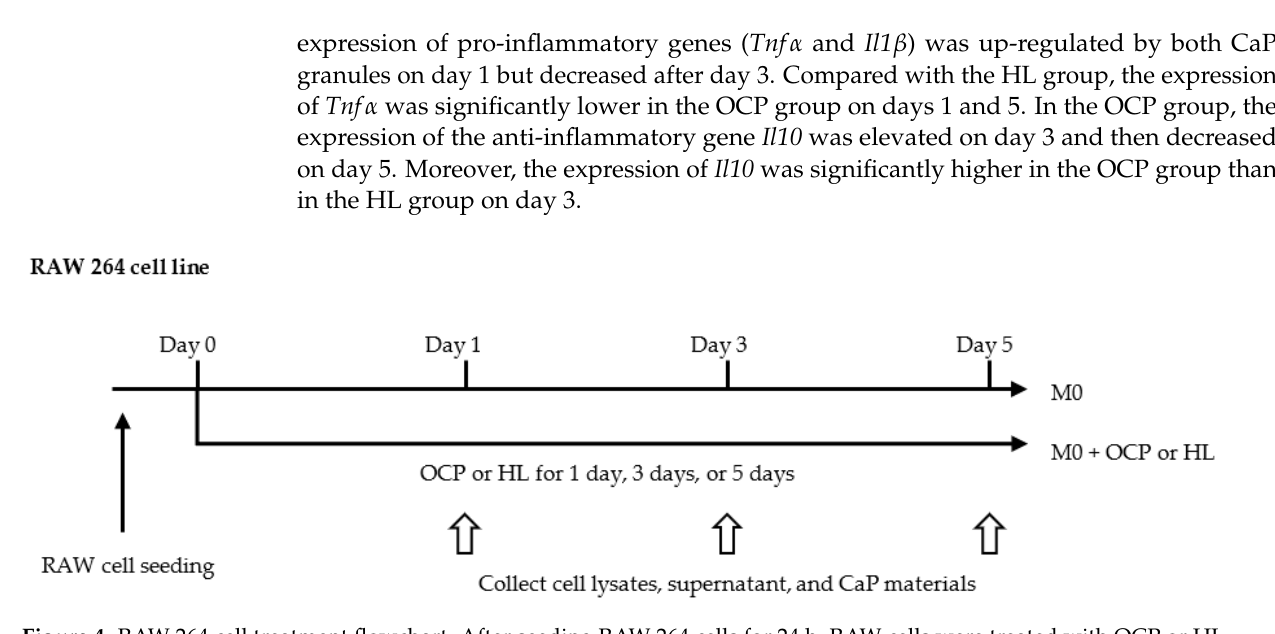
Figure 4. RAW 264 cell treatment flowchart. After seeding RAW 264 cells for 24 h, RAW cells were treated with OCP or HL granules for 1, 3, and 5 days. At each time point, the cell lysates, supernatant, and the soaked CaP granules were collected.